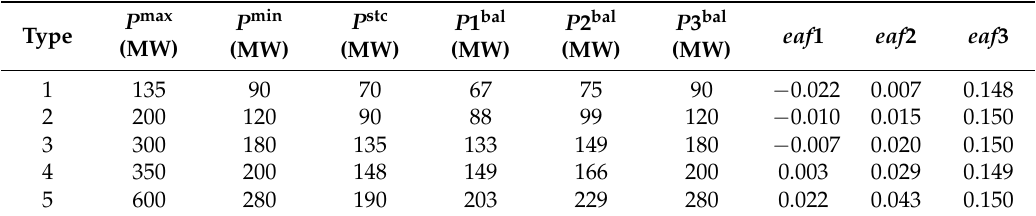
Table 8. The parameters of coal-fired units concerning